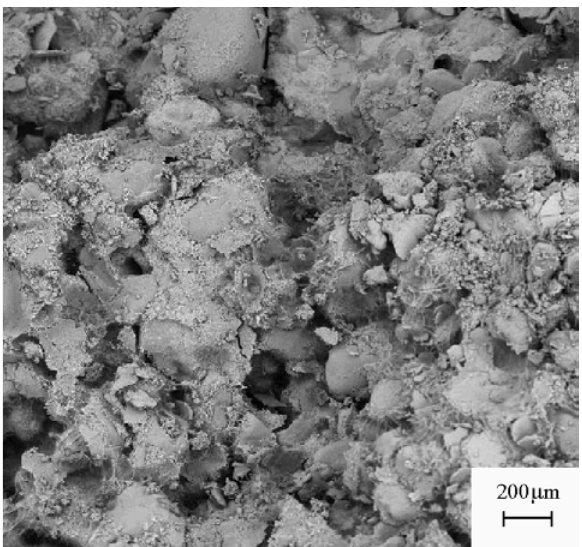
Figure 8. SEM micrograph of the porosity and aggregate/gel interface of sample (K) (CPII-Z-32 cement/10% bottom ash/sand) after 28 days of aging.